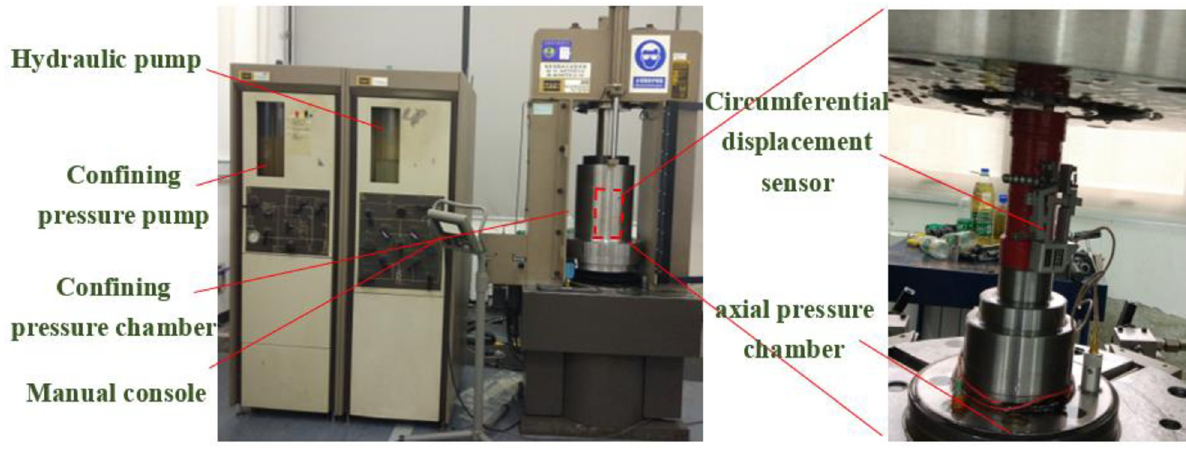
Fig 3. MTS 815 triaxial rock testing